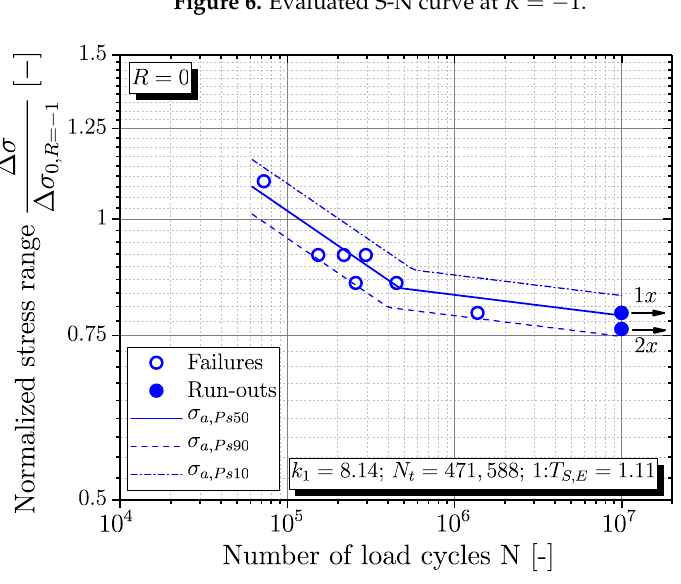
Figure 6. Evaluated S-N curve at R = − 1.